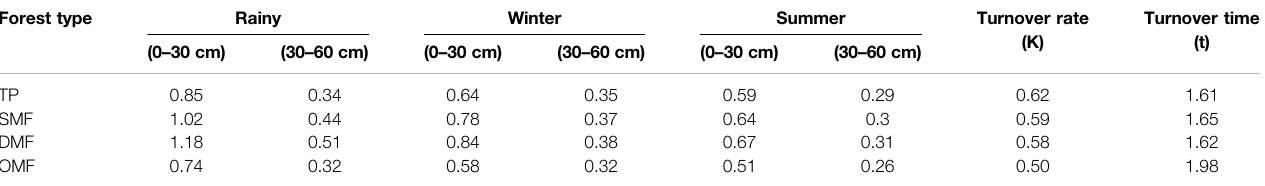
TABLE 4 | Fine Root Biomass (Mg/ha), Turnover rate (K), and Turnover time (t) of litter in Forest type during 2015 – 2019. Forest type Rainy